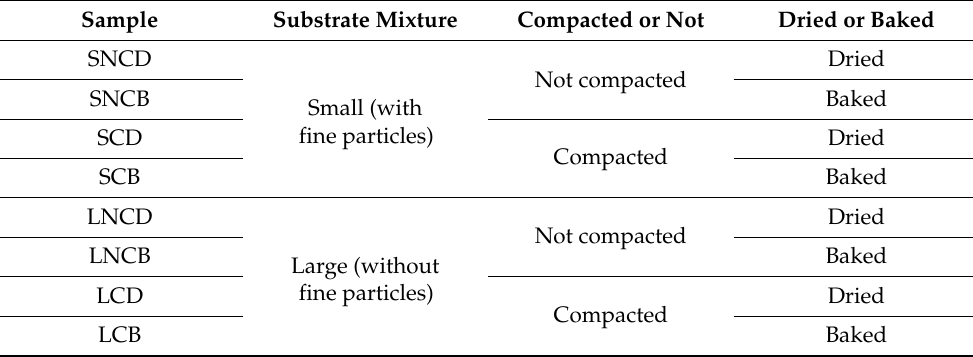
was added in front of these names: PO_ for Pleurotus ostreatus (e.g., PO_SNCD), and CC_ for Coprinus comatus (e.g., CC_SNCD).